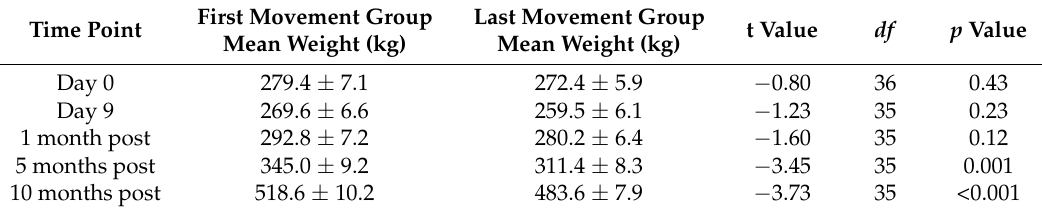
Table 3. Mean weights ± s.e.m. of heifers in the First and Last Movement Groups during and post-weaning. A linear model fitting Movement Group, birthweight and age was used to compare group means between First and Last on Day 0. Linear models fitting Movement Group and Day 0 weight were used to compare the group means at all other time points. Heifers were retrospectively grouped as First or Last depending on whether they were consistently one of the first or last 20 animals to move through the funnel during days 2–6 of acclimation testing.